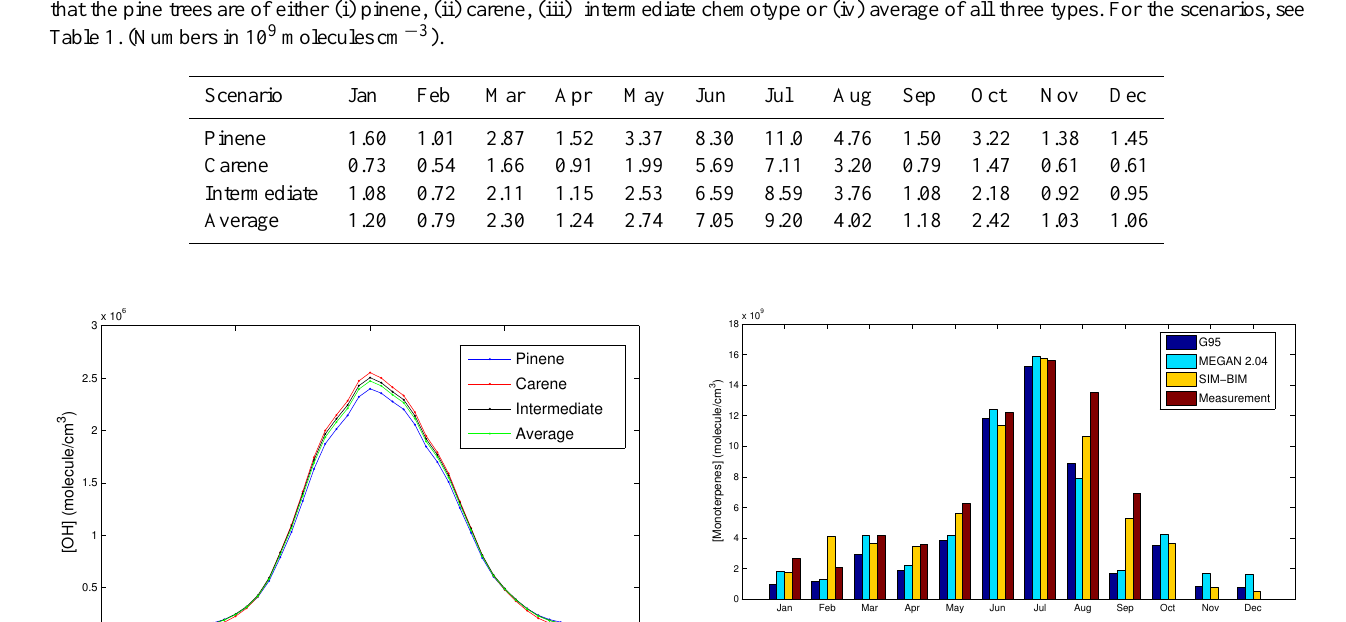
Figure 4. Comparison of modelled (G95, MEGAN 2.04, SIM– BIM) and measured (at the SMEAR II station) average monthly monoterpene concentrations at 4m height for the year